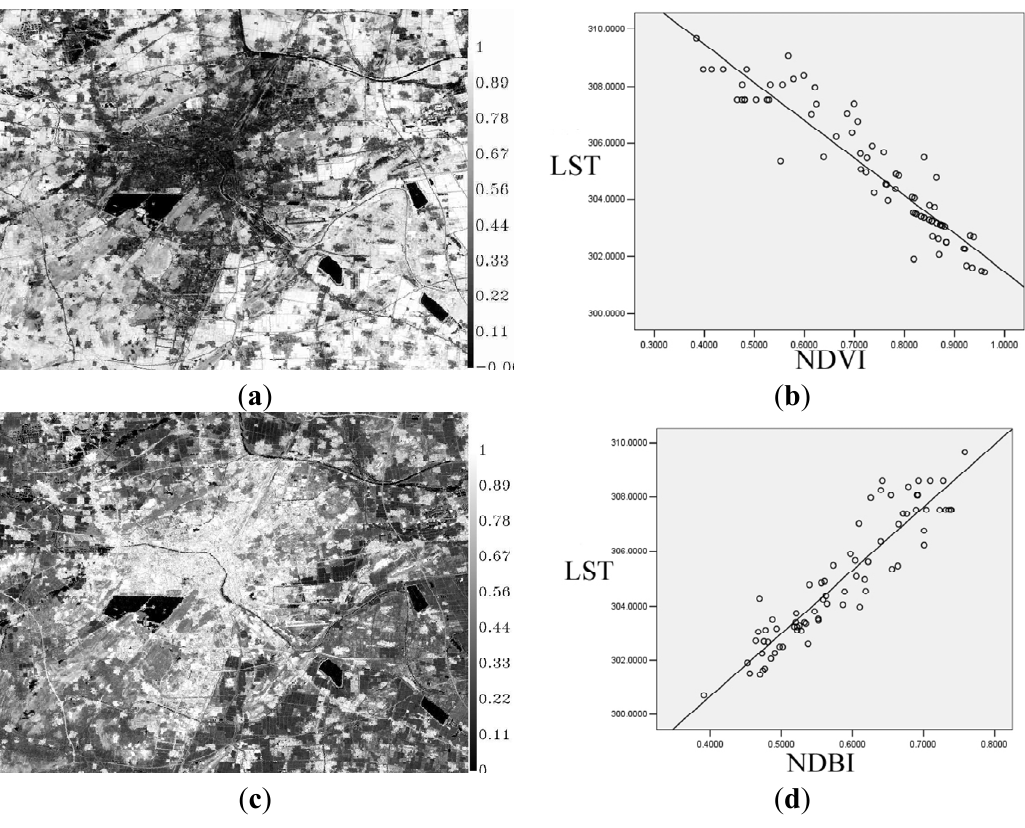
Figure 6. NDVI, NDBI and their relationships between LST. ( a ) NDVI map; ( b ) Relationship between LST and NDVI; ( c ) NDBI map; ( d ) Relationship between LST and NDBI.